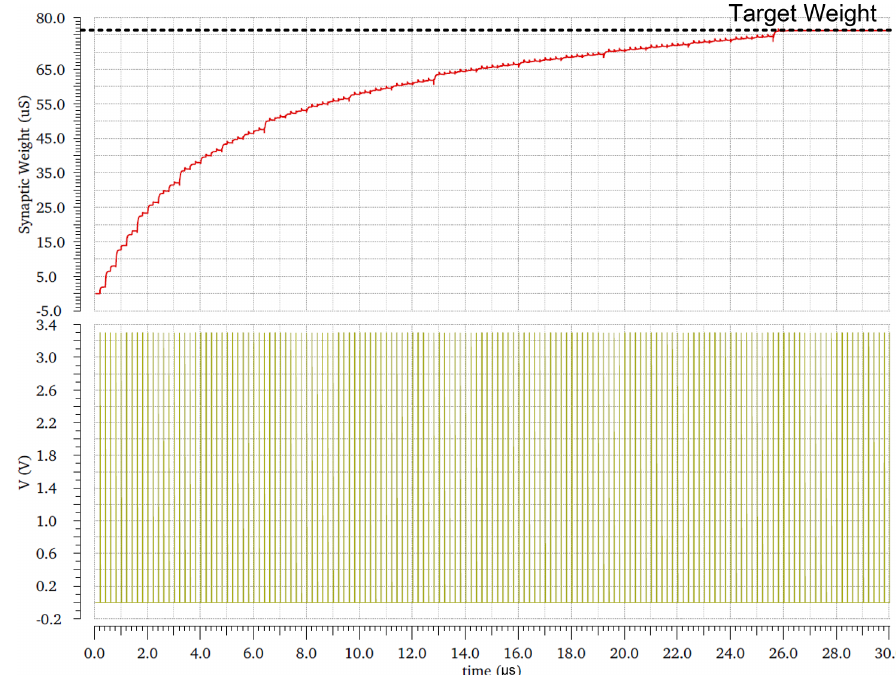
Figure 34. Target weight at V LEAK equal to 1.5V, vg1 and vg2 equal to 1V, and V RFR equal to 800mV. Circuit conditions are V dd of 3 . 3V, and temperature equals 27 ◦ C and on the nominal